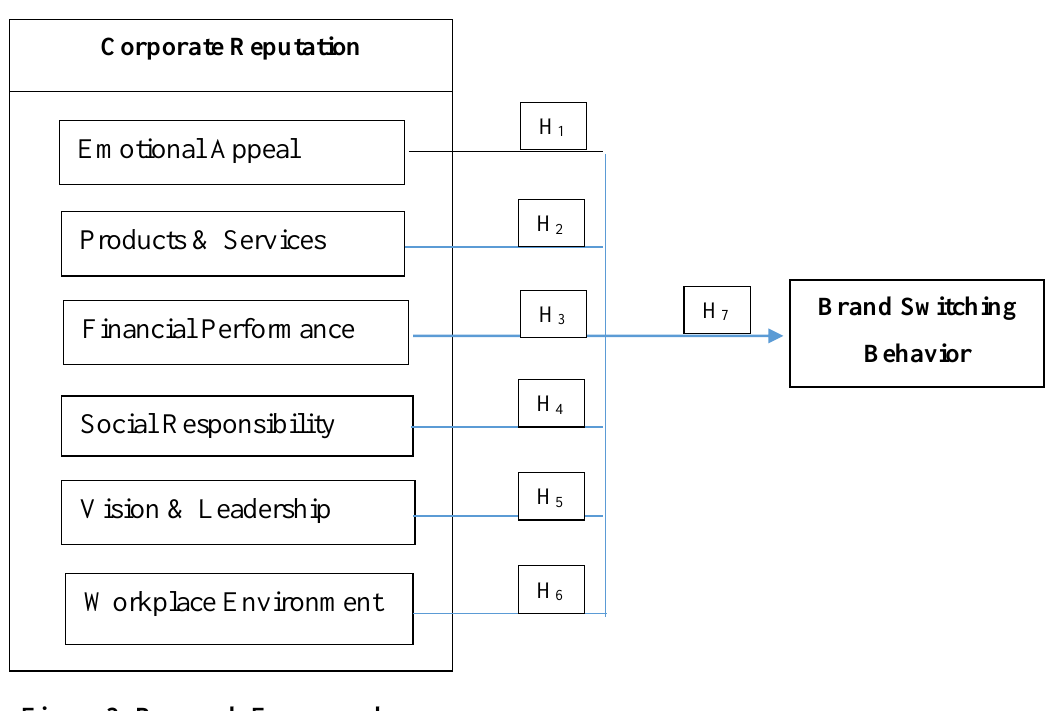
Figure 3: Research Framework This study is an empirical and needed both primary and secondary